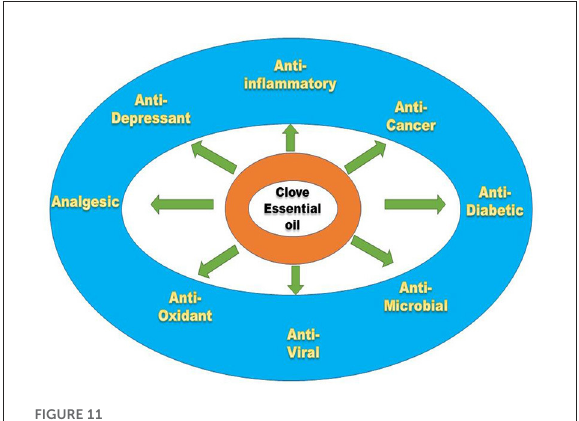
FIGURE11 Bioactive potentials of clove essential oil